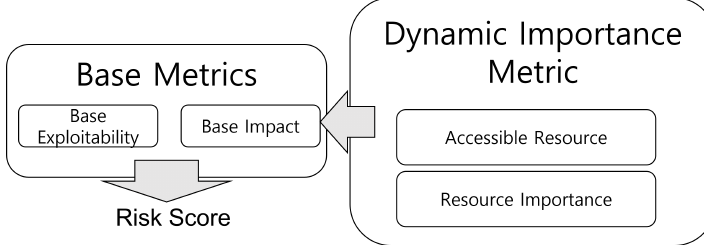
Figure 5. Overview of Dynamic Importance Metric with Base Metrics.